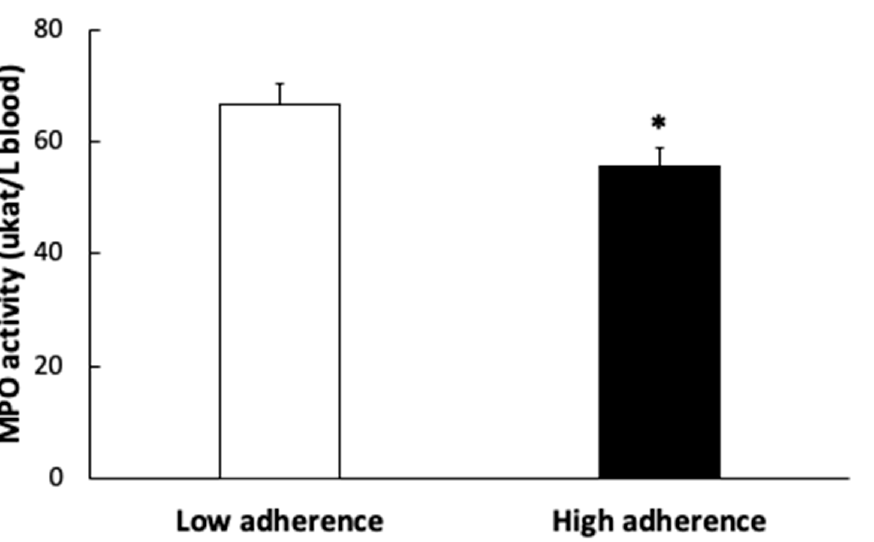
Figure 3. Plasma myeloperoxidase (MPO) enzymatic activity of patients according to the Mediter- ranean Dietary Pattern score. Results are presented as mean ± SEM. Data points in bold (*) are significant ( p < 0.05) by Student t -test.